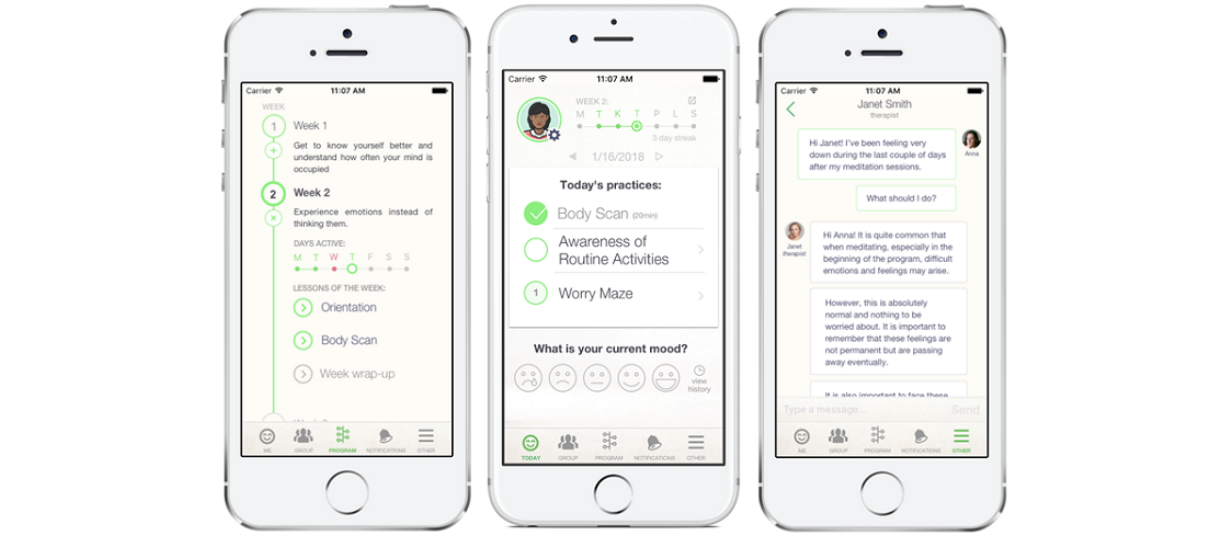
Figure 1. Meru Health Program version 2.0